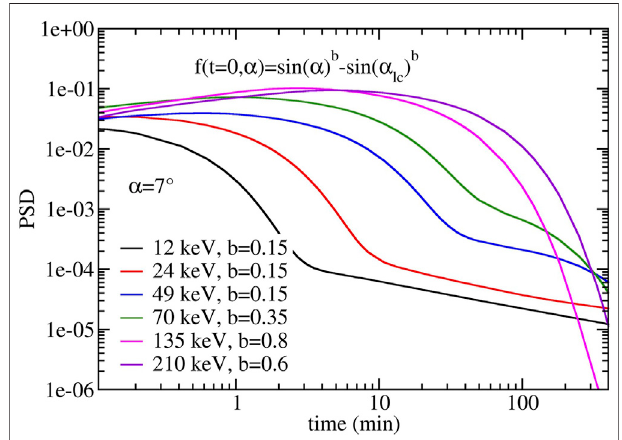
FIGURE 9 | Predicted phase-space density at the loss cone edge ( α (cid:1) 7.95 ° ) for a range of energies ( E (cid:1) 12, 24, 49, 70, 135, 210 keV). PSD growth can occur during the fi rst ∼ 10 min after which the PSD starts decaying abruptly.